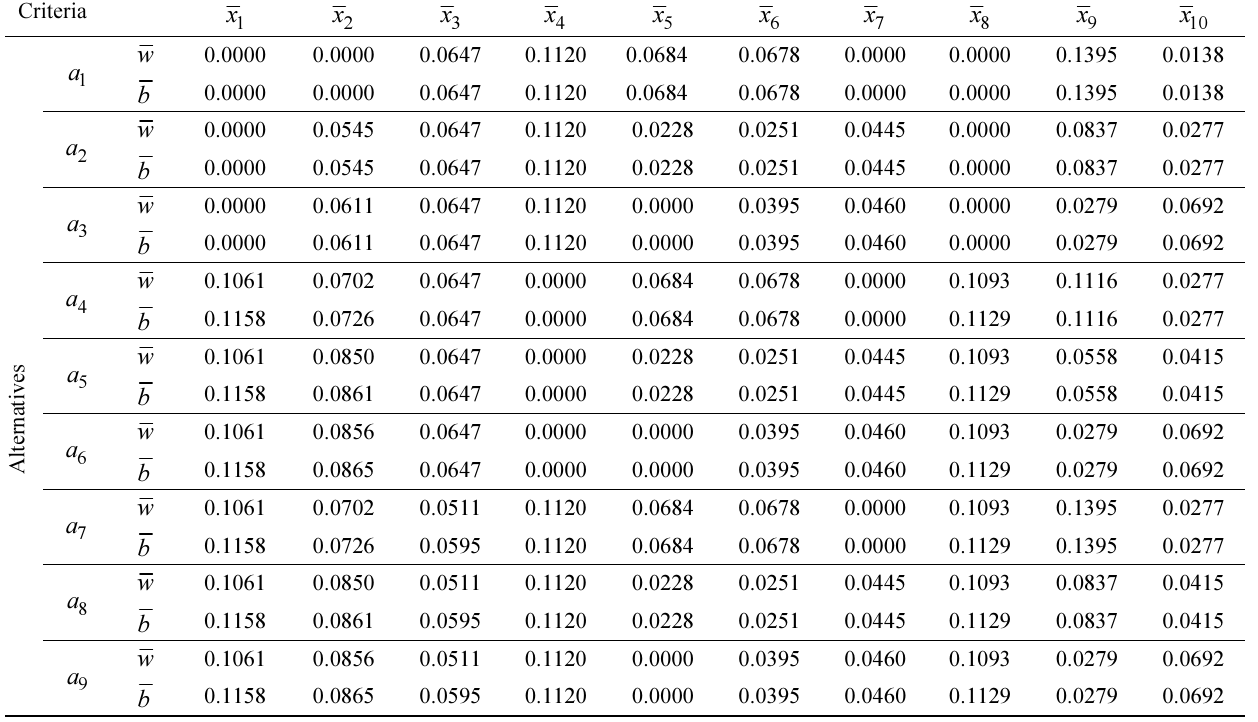
Table 4. Normalised-weighted decision-making